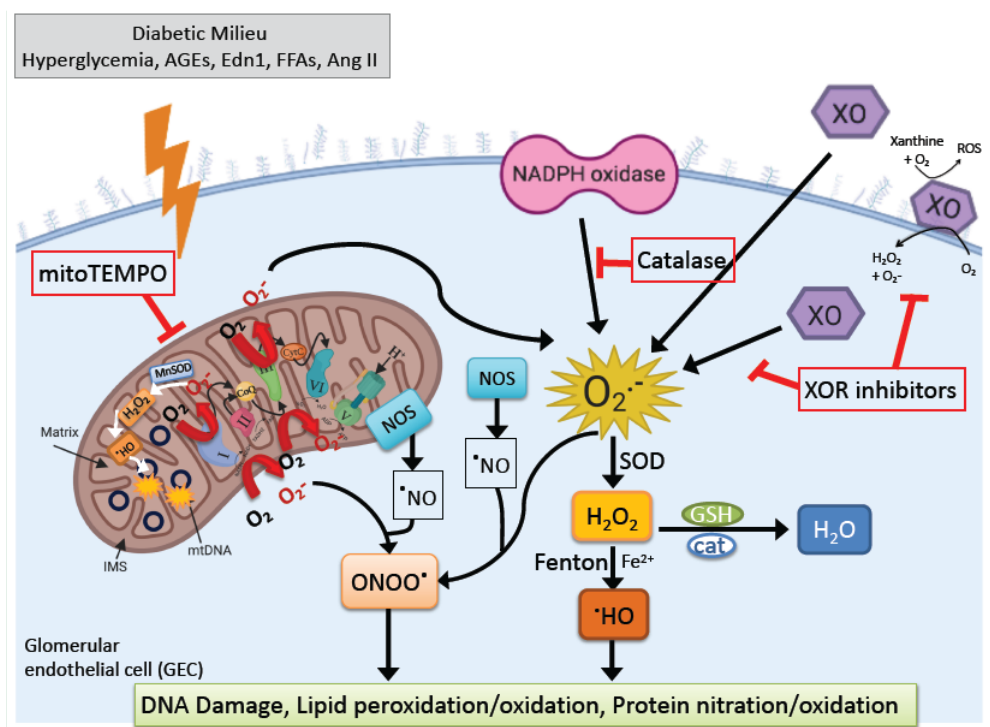
Figure 2. Generation of excess reactive oxygen species (ROS) in the GECs. Pathological metabolic conditions associated with diabetes mellitus (including hyperglycemia, increased circulation of advanced glycation end products (AGEs), endothelin-1 (Edn1) and free fatty acids (FFAs), as well as activation of RAAS leading to release of angiotensin II (Ang II)) can exacerbate ROS production over the cell’s antioxidant capacity, and this imbalance contributes to endothelial dysfunction in DKD. ROS are generated by enzymatic and nonenzymatic redox reactions during cellular metabolism under normal and pathological conditions. The superoxide anion (O 2 • − ), generated in mitochondria, plasma membrane, peroxisomes, and cytosol, becomes the precursor free radical for the generation of other ROS molecules. Next, cytosolic CuZN superoxide dismutase (SOD) and mitochondrial MnSOD